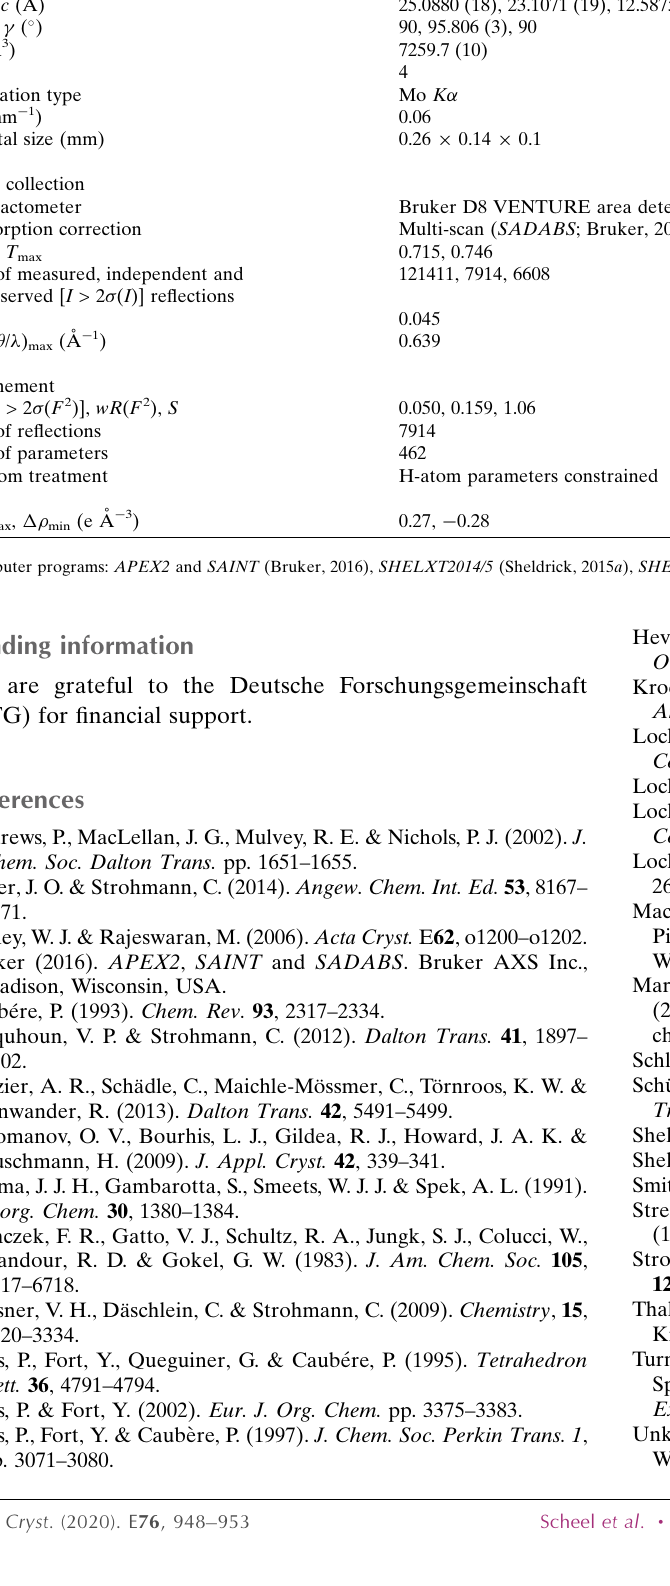
Crystal data Chemical